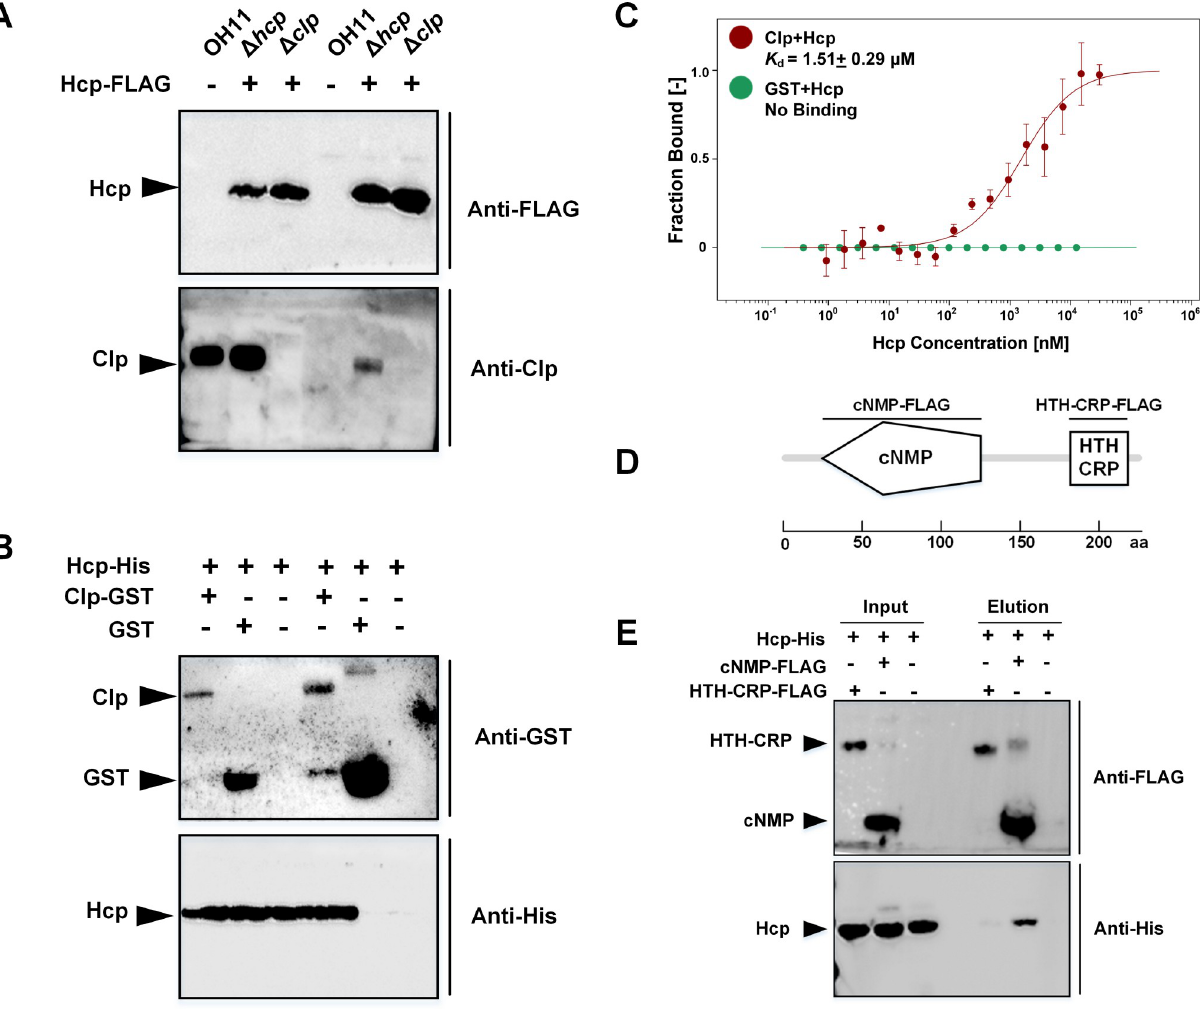
Fig 3. Hcp binds the transcription factor Clp. (A) Co-IP assays uncovering the Hcp-Clp interactions. Hcp-FLAG indicates a plasmid expressing hcp- FLAG in the Δ hcp or Δ clp mutants. Co-IP was carried out using cell extracts and magnetic beads coated with anti-FLAG antibodies. Proteins on the Western blot were detected by using Anti-Clp polyclonal antibody or Anti-FLAG antibody. (B) GST-Clp—Hcp-His 6 pull-down assay confirming Hcp- Clp interactions. GST was served as negative control. The western blot was performed by using Anti-GST or Anti-His antibodies. (C) Microscale thermophoresis (MST) showing that GST-Clp binds Hcp-His 6 ( K d , 1.51 μ M) (red trace), while GST does not bind Hcp-His 6 (green trace). Constant concentration (10 μ M) of the fluorescently labeled target protein (GST-Clp or GST) was titrated against increasing concentrations of unlabelled Hcp- His 6 . (D) A scheme showing the domain architecture of Clp comprising the cNMP-binding domain and the DNA-binding, HTH-CRP, domains. The HTH-CRP-FLAG was expressed as an N-terminal fusion to the 11-kDa Lipolyl tag (plasmid pOPTHisLip) to improve protein solubility [41]. The size of the Lipolyl-tag-HTH-CRP-FLAG is 18 kDa. The size of the cNMP-FLAG is 12 kDa (E) FLAG pull-down assay showing that Hcp interacts with the cNMP-binding domain of Clp.